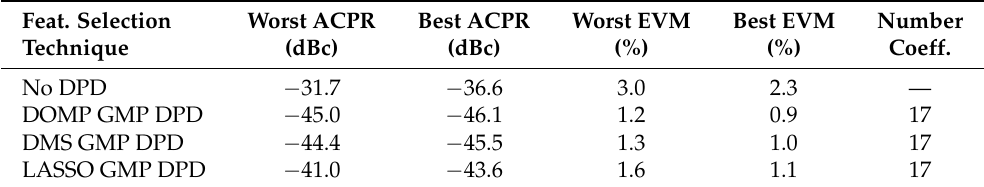
Figure 15. The 64-QAM constellations before and after DPD linearization, considering 41 coefficients of a GMP behavioral model selected with DOMP. Table 2. Linearization results obtained with a GMP DPD and considering a 4 × LTE20 signal over 120 MHz instantaneous